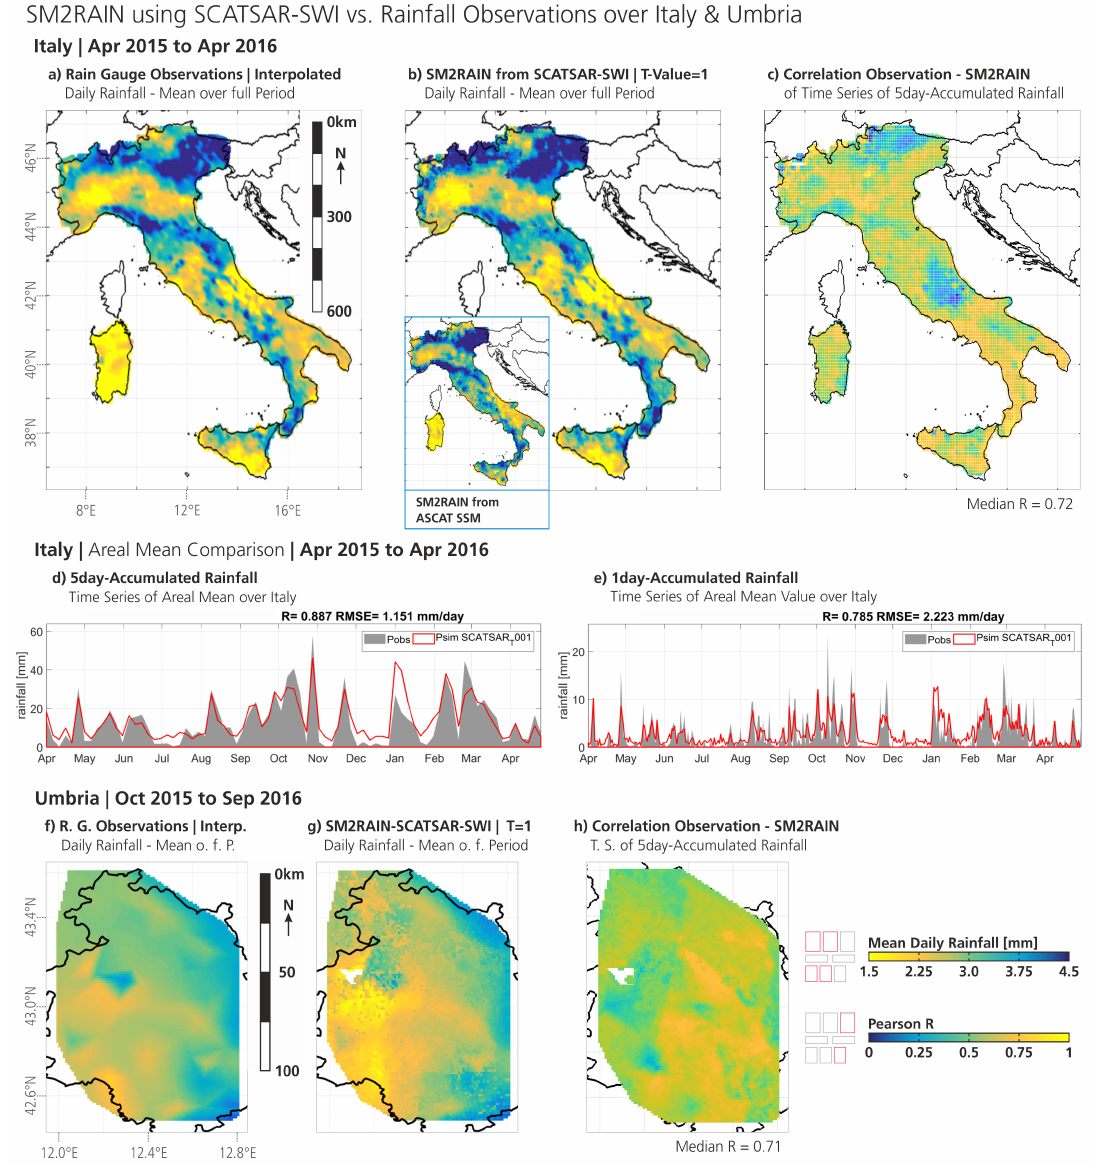
Figure 8. SM2RAIN estimates using SCATSAR-SWI data as input, compared to observed rainfall. ( a ) observed daily mean rainfall over Italy, averaged over April 2015–April 2016; ( b ) as ( a ) but from SM2RAIN using SCATSAR-SWI with T -value = 1, and with mini-map showing the result from SM2RAIN using ASCAT SSM as input; ( c ) correlation between 5 day-accumulated rainfall from observations and SM2RAIN-SCATSAR-SWI; ( d ) time series of the areal mean over Italy of five-day-accumulated rainfall from observations and SM2RAIN; ( e ) as ( d ) but for one-day-accumulated rainfall; ( f – h ) as ( a – c ) but for Umbria during the period October 2015–September